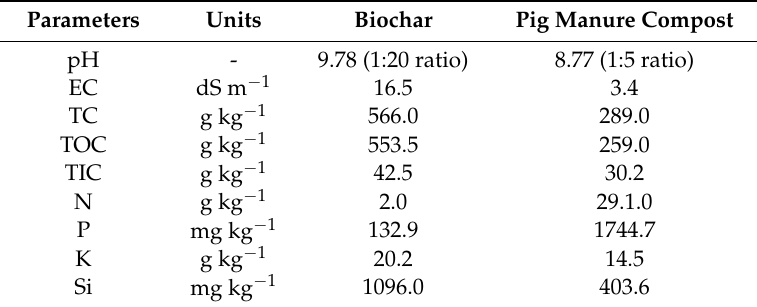
Table 1. Characteristics of biochar and pig manure compost used 1.